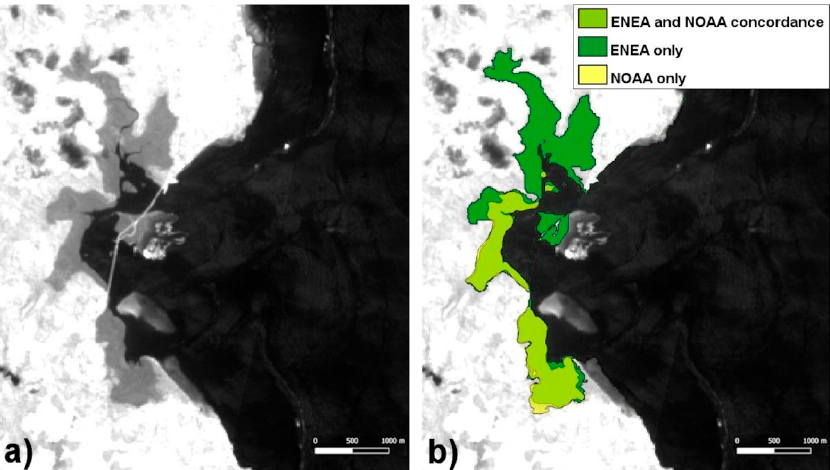
Figure 11. ( a ) A detail of the east sector of the Republic of Palau, with Sentinel-2 enhanced Band 11, where dark grey is the mangrove cover; ( b ) mangrove cover diachronic map showing a concordance wide area of mangroves identified by ENEA and NOAA (light green); two discordance areas with ENEA mangrove cover only (dark green) and NOAA mangrove cover only (yellow), respectively.